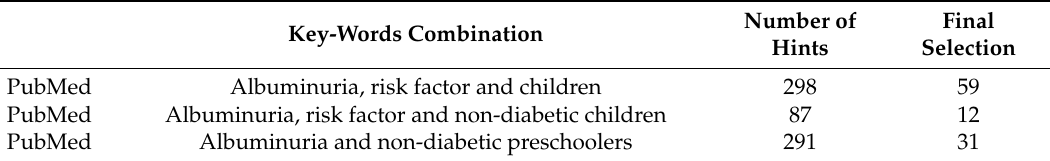
Table 1. Keyword combination and PubMed